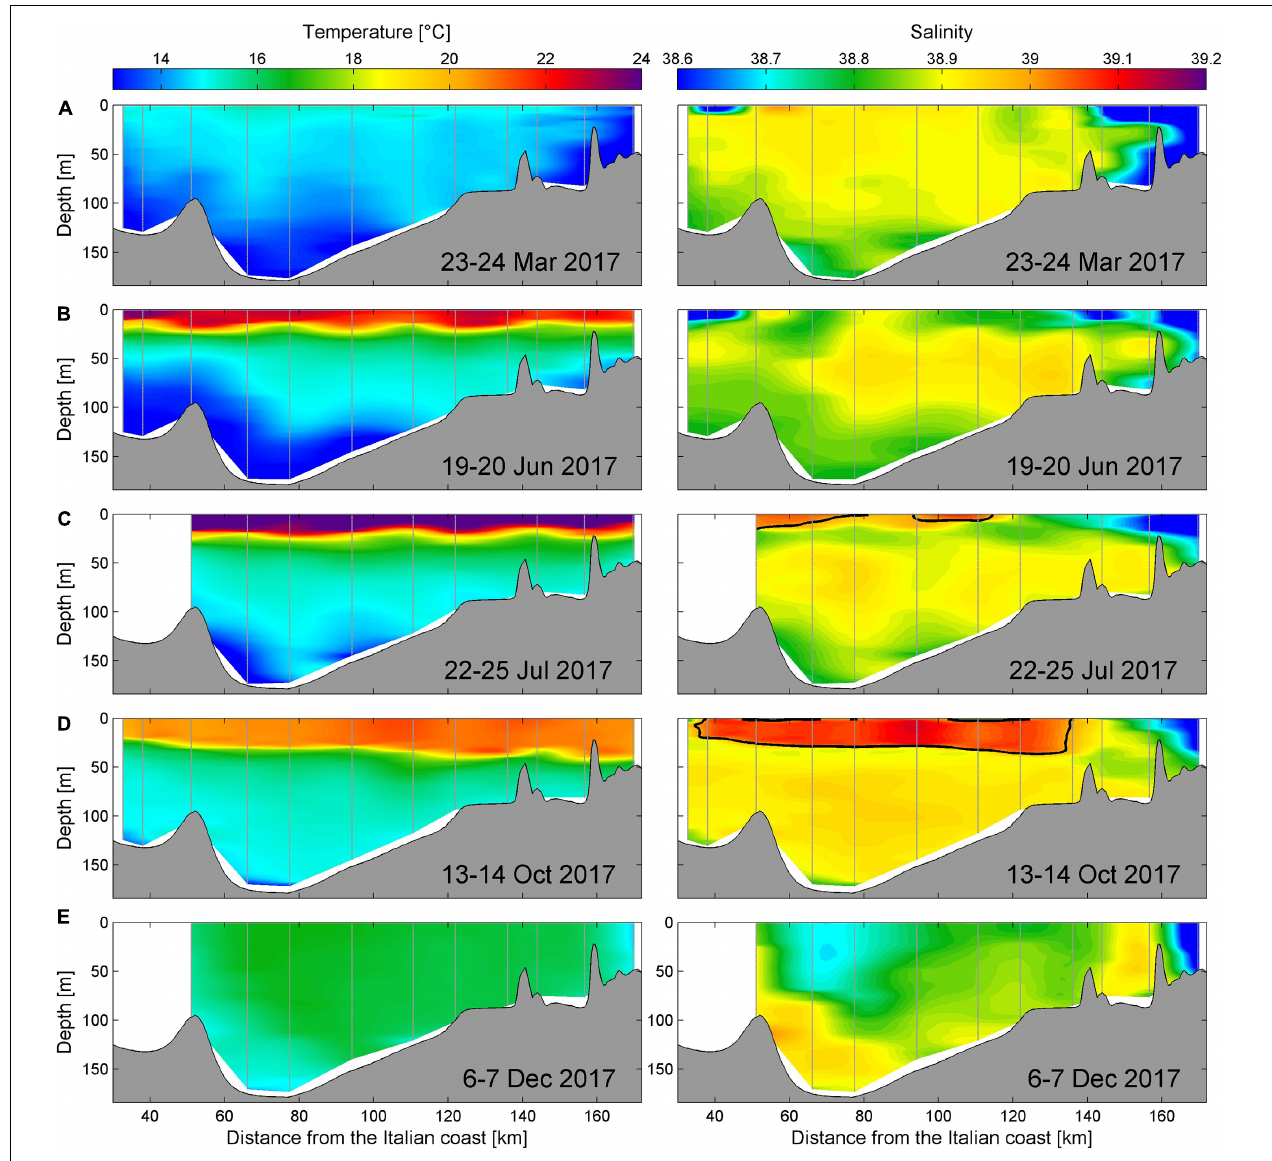
FIGURE 2 | Temperature and salinity measured at the Palagruža Sill transect: (A) 23–24 March 2017, (B) 19–20 June 2017, (C) 22–25 July 2017, (D) 13–14 October 2017 and (E) 6–7 December 2017. Salinity values higher than 39.0 are encircled with black line in salinity plots. Vertical gray lines denote CTD